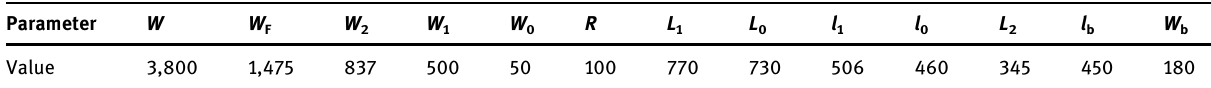
Table 1: Geometrical dimensions ( mm )